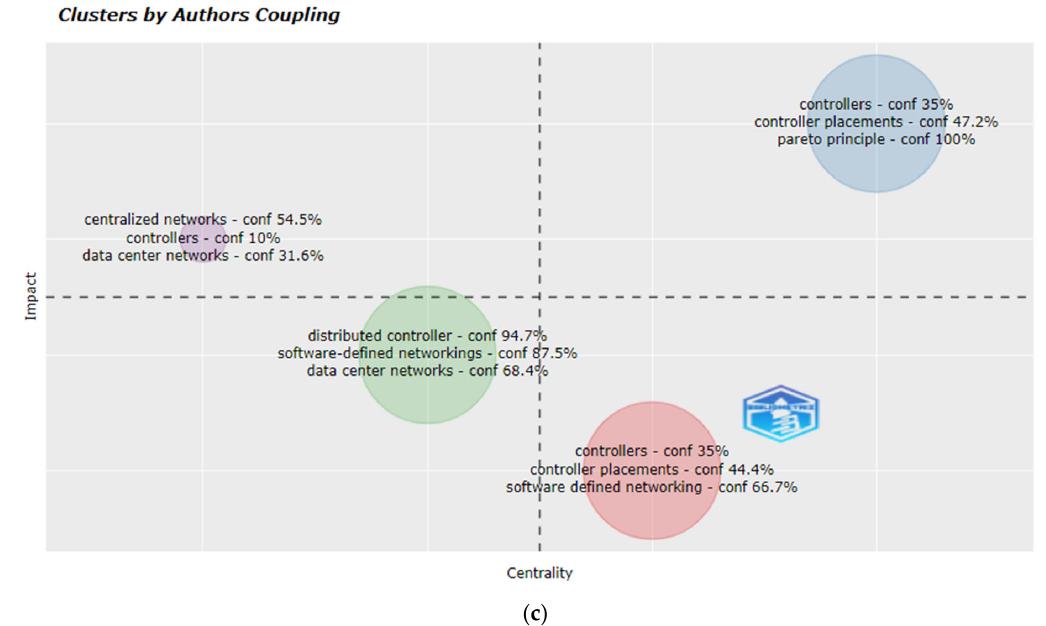
Figure 10. ( a ): Three fields ‐ plot between the authors, keywords plus, and countries through Biblioshiny. ( b ): Most relevant sources and cumulative numbers of research documents related to SDN controllers. ( c ): Clusters by authors coupling.